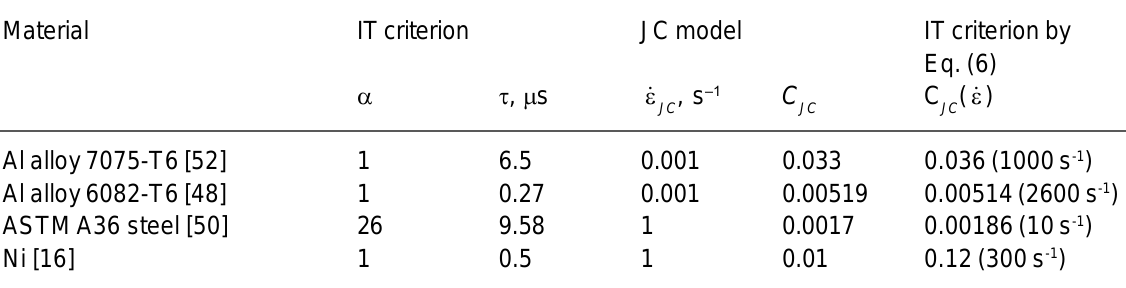
Table 2. Definition of parameters of JC model by IT criterion and comparison these parameters with original